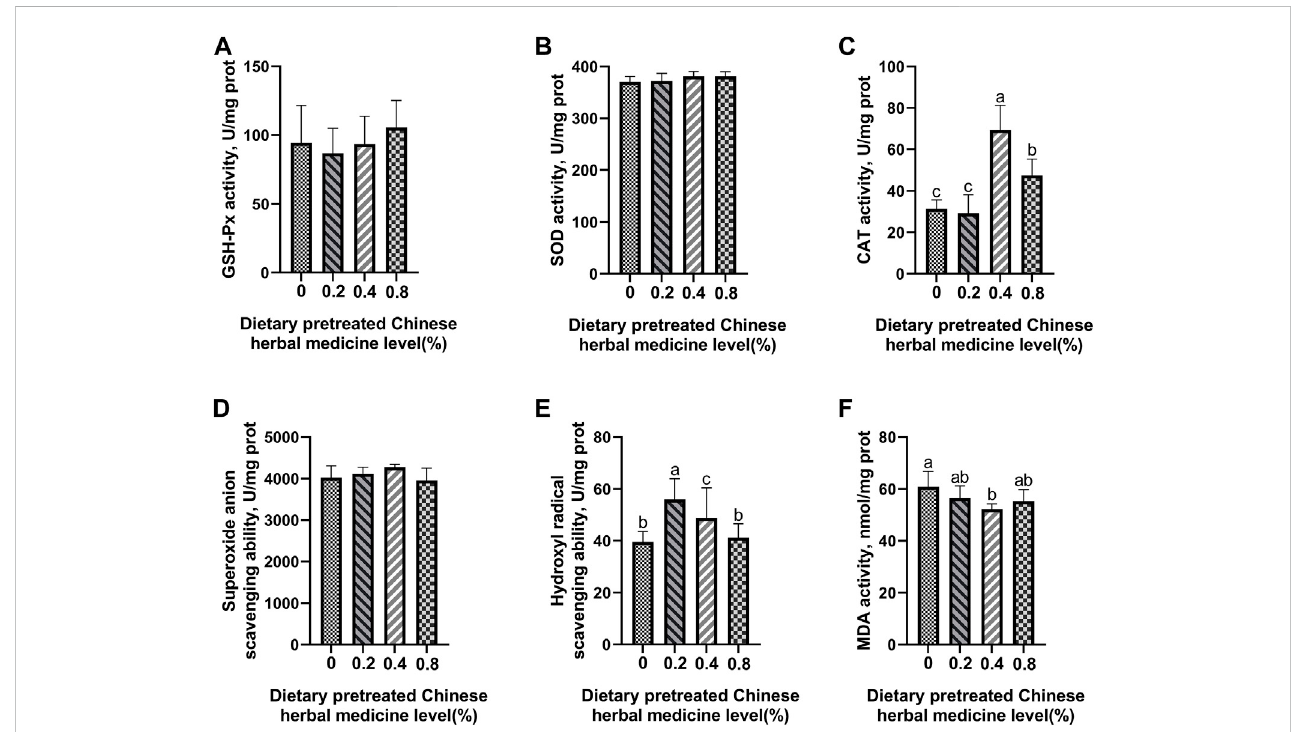
FIGURE 5 Effect of dietary PCHM supplementation on the antioxidant enzyme activity and free radicals in the uterus of late-phase laying hens. (A – C) Glutathione peroxidase (GSH-Px), superoxide dismutase (SOD), and catalase (CAT) activity in the uterus . (D,E) Scavenging free radical abilities in the uterus. (F) Malondialdehyde (MDA) level in the uterus. Values are expressed as means ± SEM of six birds per treatment. Means without a common letter differ ( p < 0.05).